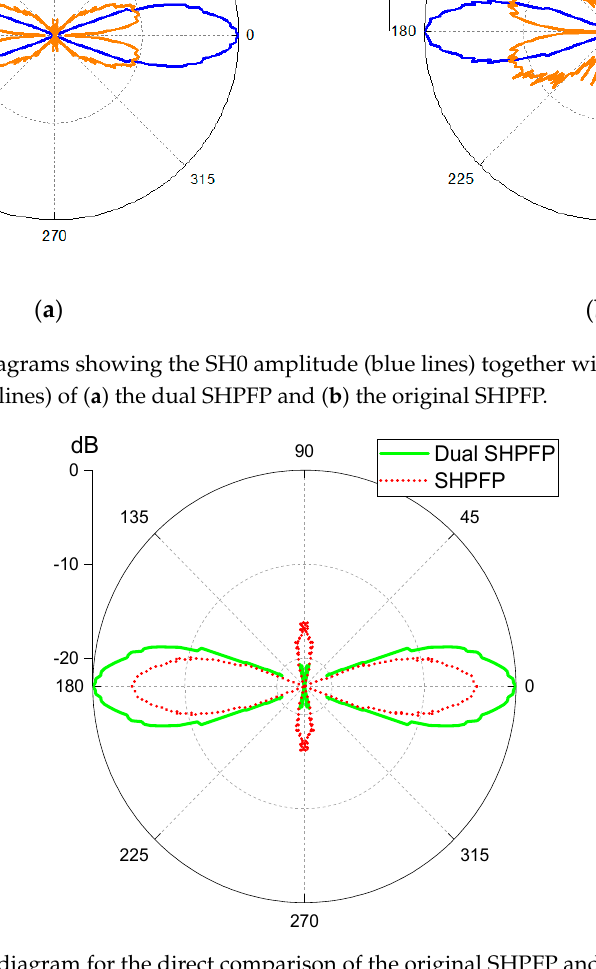
Figure 20. A polar diagram for the direct comparison of the original SHPFP and the dual SHPFP as a SH0 wave transducer. The solid green and the dotted red lines show the SH0 amplitude of the dual SHPFP and the original SHPFP, respectively. The values are scaled to the maximum of the dual SHPFP.